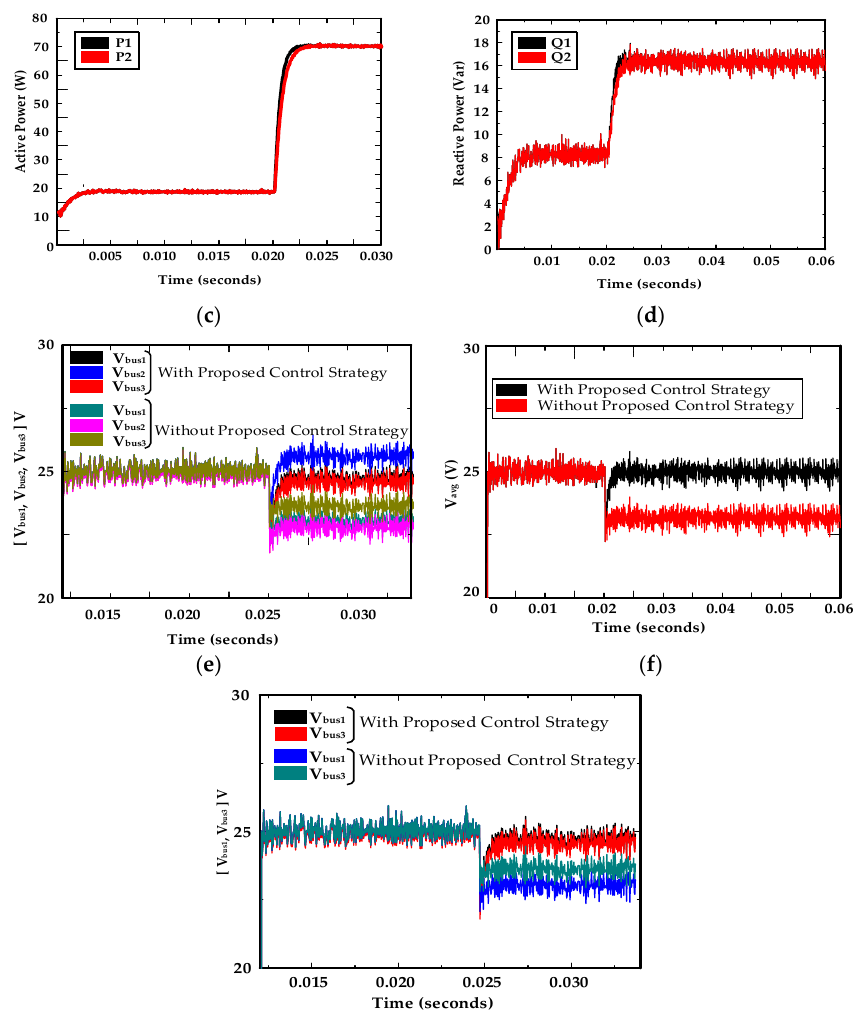
Figure 12. Experiments results. ( a ) Active power response without proposed control scheme. ( b ) Reactive power response without proposed control scheme. ( c ) Proportional active power sharing proposed control scheme. ( d ) Proportional reactive power sharing with proposed control scheme. ( e ) Three buses V bus1 , V bus2 and V bus3 response. ( f ) Average voltage response of V bus1 , V bus2 and V bus3 ( g ) V bus1 and V bus3 voltage response.